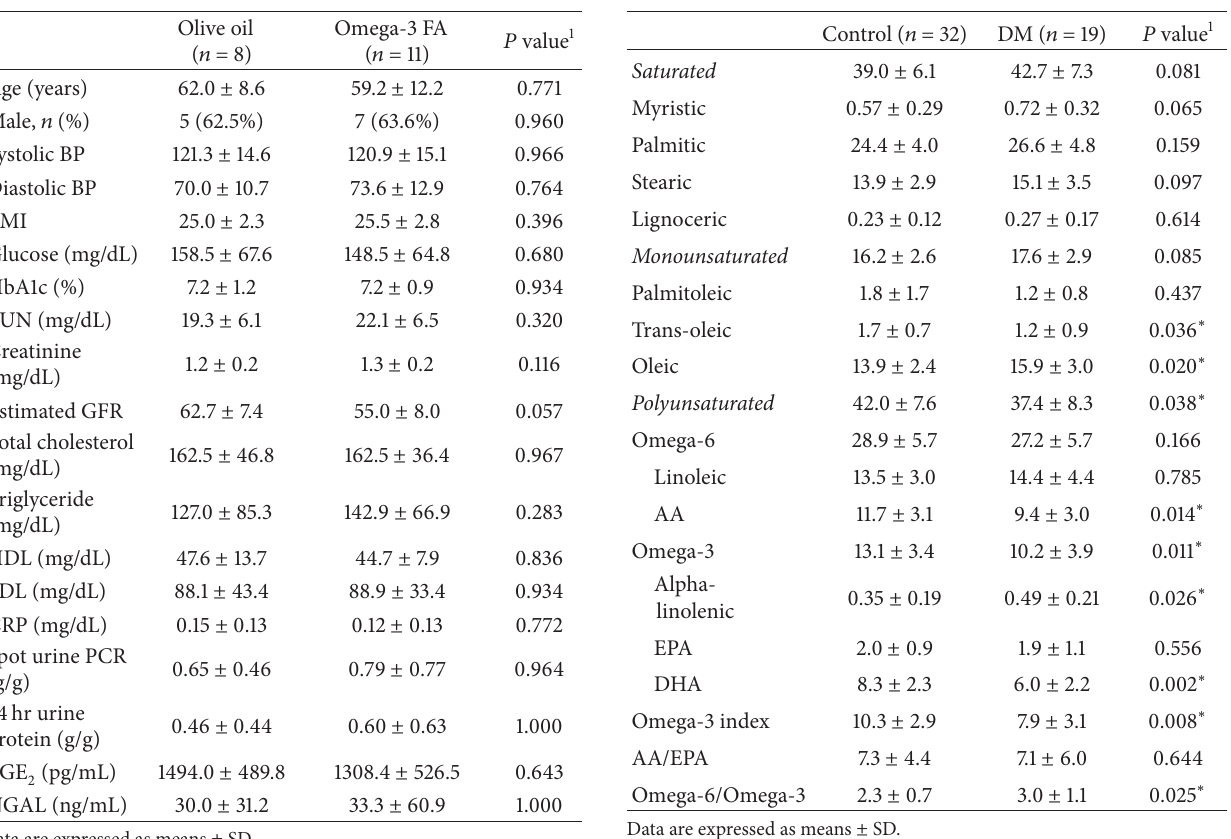
Table 1: Clinical blood biochemical analyses of the subjects. Table 2: Comparison of erythrocyte membrane fatty acids